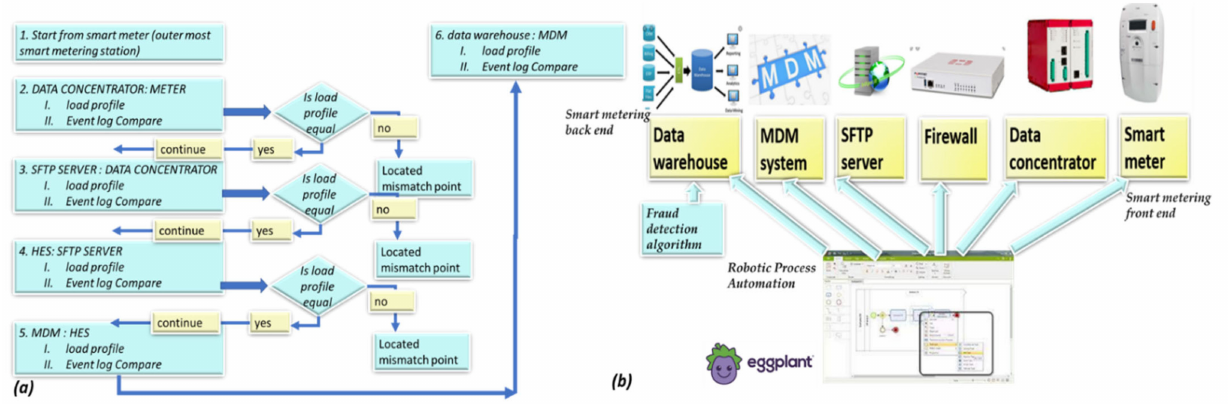
Figure 7. ( a ) RPA sub-algorithm flow diagram. ( b ) Illustration of implementation using the Egg- plant [32] software automation platform: comparison of energy load profile and reading meter event log file—enables loss location. Eggplant symbol and GUI is taken from Eggplant website with